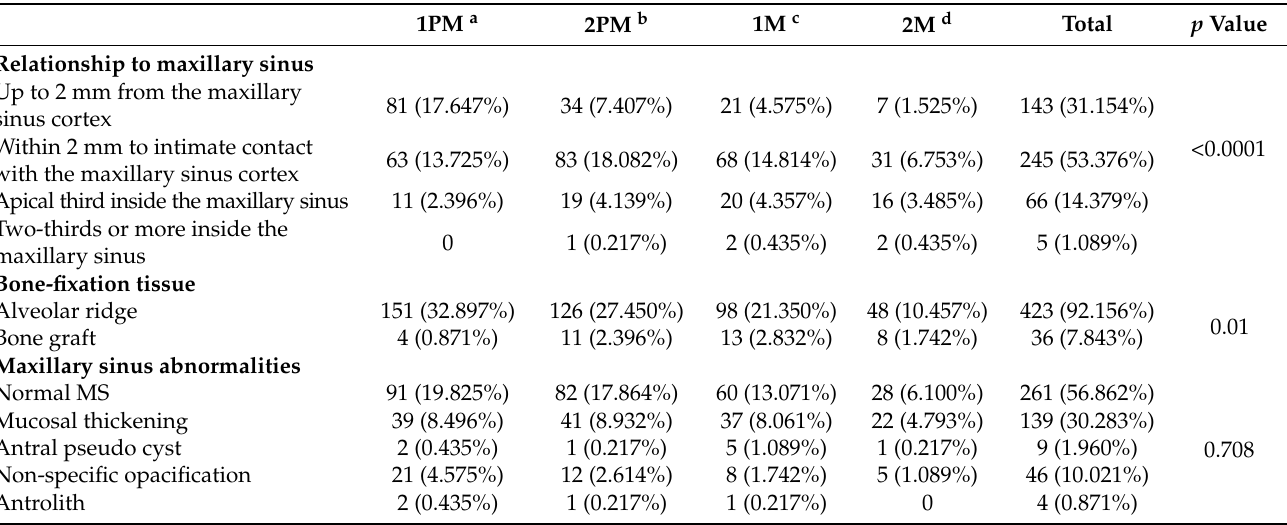
Table 1. Distribution of implants by insertion site, according to relationship to the maxillary sinus, bone-fixation tissue and sinus abnormalities.